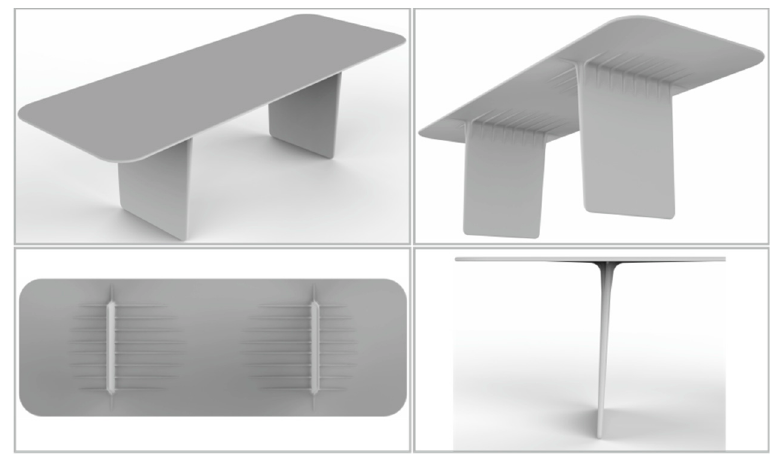
Figure 1. Nervi Table renderings.